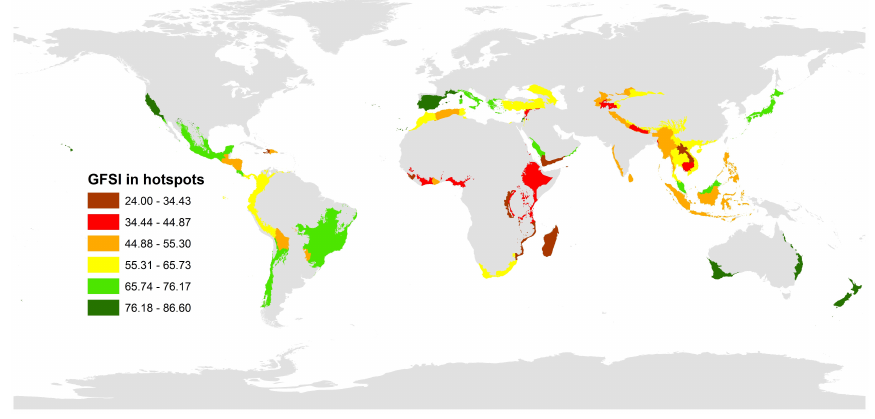
Figure 3. Overlay of biodiversity hotspots and Global Food Security Index (GFSI).